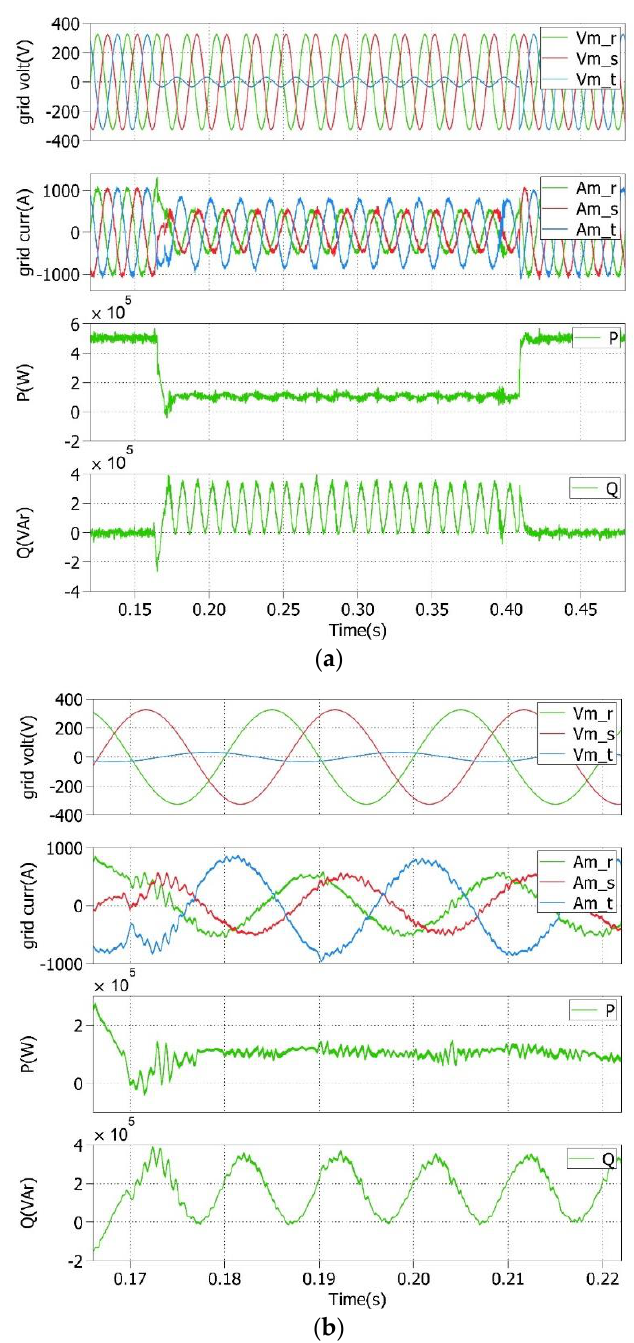
Figure 6. ( a ) Grid voltages, currents, and P and Q during an asymmetrical deep voltage sag of 90% in phase 3; ( b ) detailed view during the faulty operating conditions.